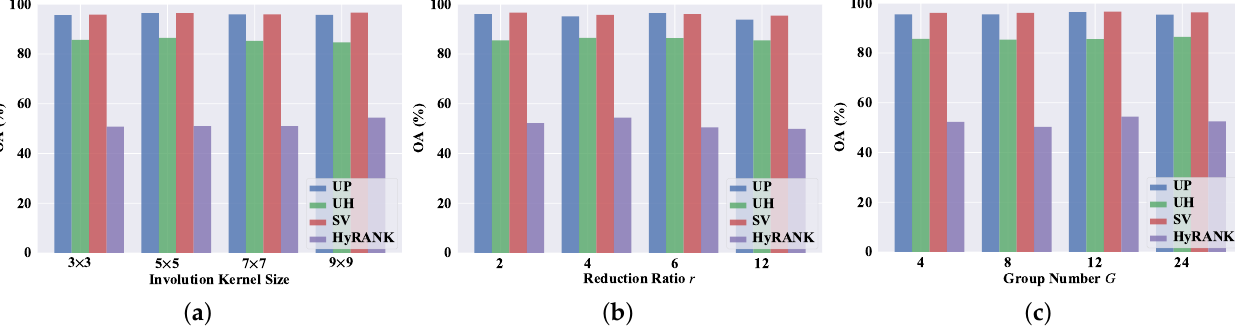
Figure 12. Results of the proposed DRIN when varying: ( a ) the involution kernel size; ( b ) the reduction ratio r ; ( c ) the group number G